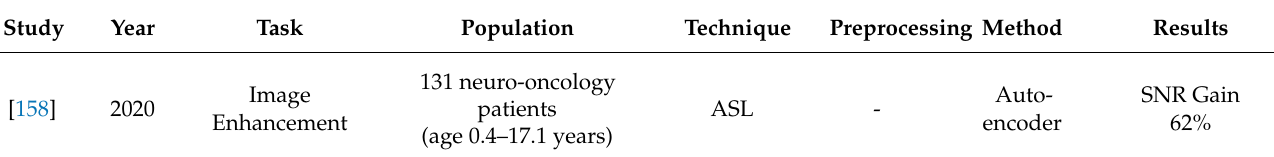
Table 6. Optimizing MRI brain imaging and